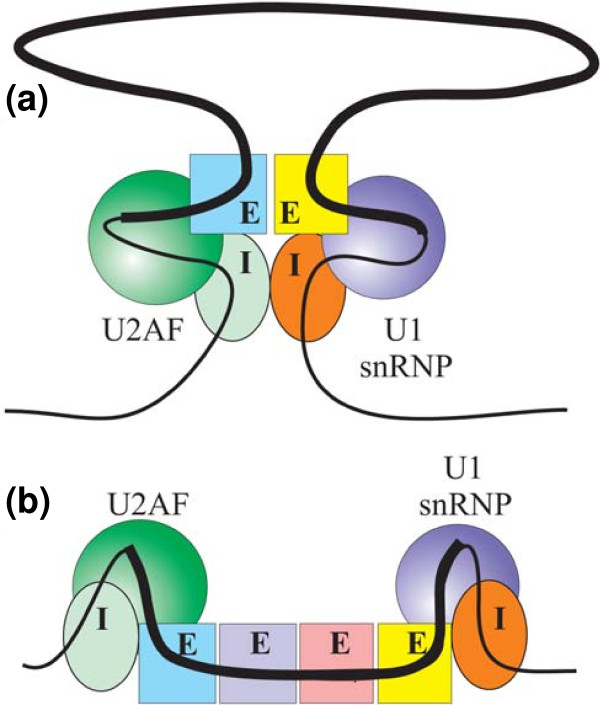
Models for the role of ISE pairs in exon definition. (a) Proteins binding the co-occurring motif ISE pairs specifically interact with each other as well as factors such as SR proteins binding to two ESEs. This tetrapartite complex can recruit the initial components of the splicing machinery, U1 small nuclear ribonucleoprotein (snRNP) and U2AF, to produce an exon definition complex in which the two ends of the exon are brought together, with much of the exon looped out. It is this complex that can undergo subsequent steps leading to intron definition and splicing. If any one of the four components is missing, the complex is too unstable and efficient recruitment is not realized. (b) Proteins binding the co-occurring motif ISE pairs interact specifically with factors such as SR proteins bound to terminally located ESEs. The ESE bound factors interact with additional ESE-binding factors so as to span the entire exon, and it is this exon-wide complex that represents exon definition. The loss of any one component results in destabilization of the complex and loss of exon definition. In either model, some exons may require ISEs and their binding proteins for sufficient stabilization while for others strong ESEs may suffice.